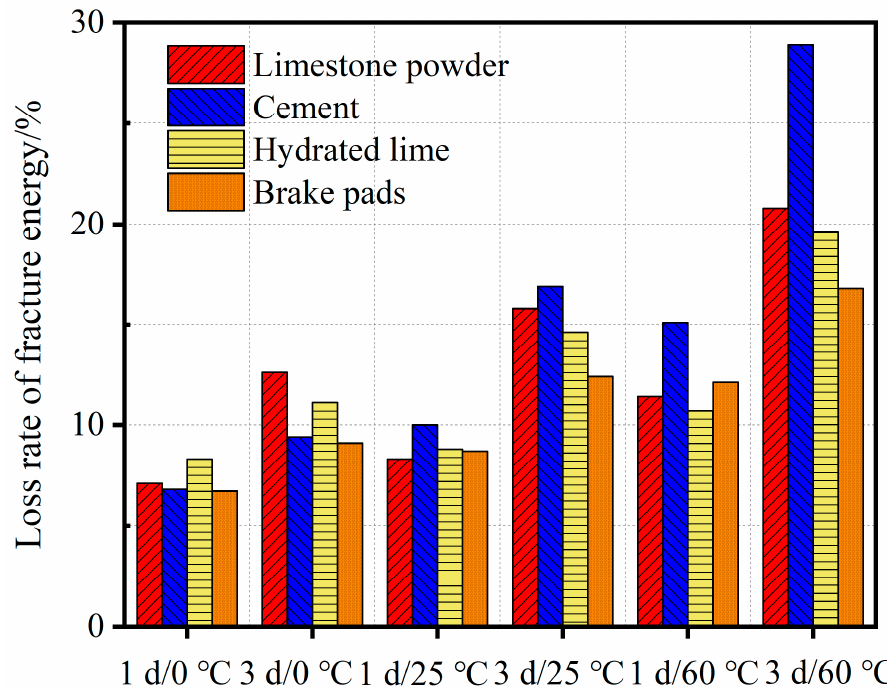
Figure 9. FE loss rates of the asphalt mixtures after water saturation.